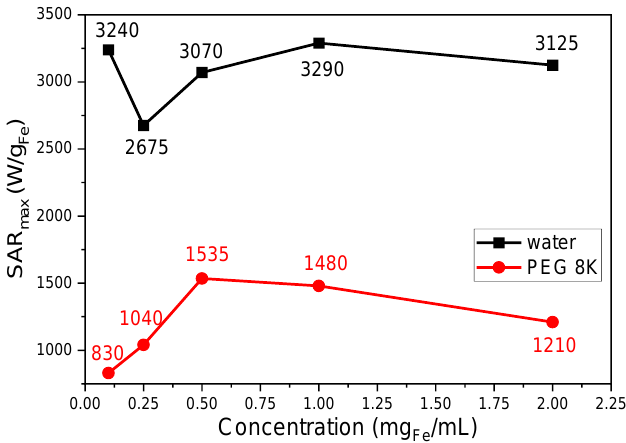
Figure 2. SAR max dependence on the concentration of the Zn ferrites for the samples suspended in water or immobilized in a solid matrix PEG 8K.